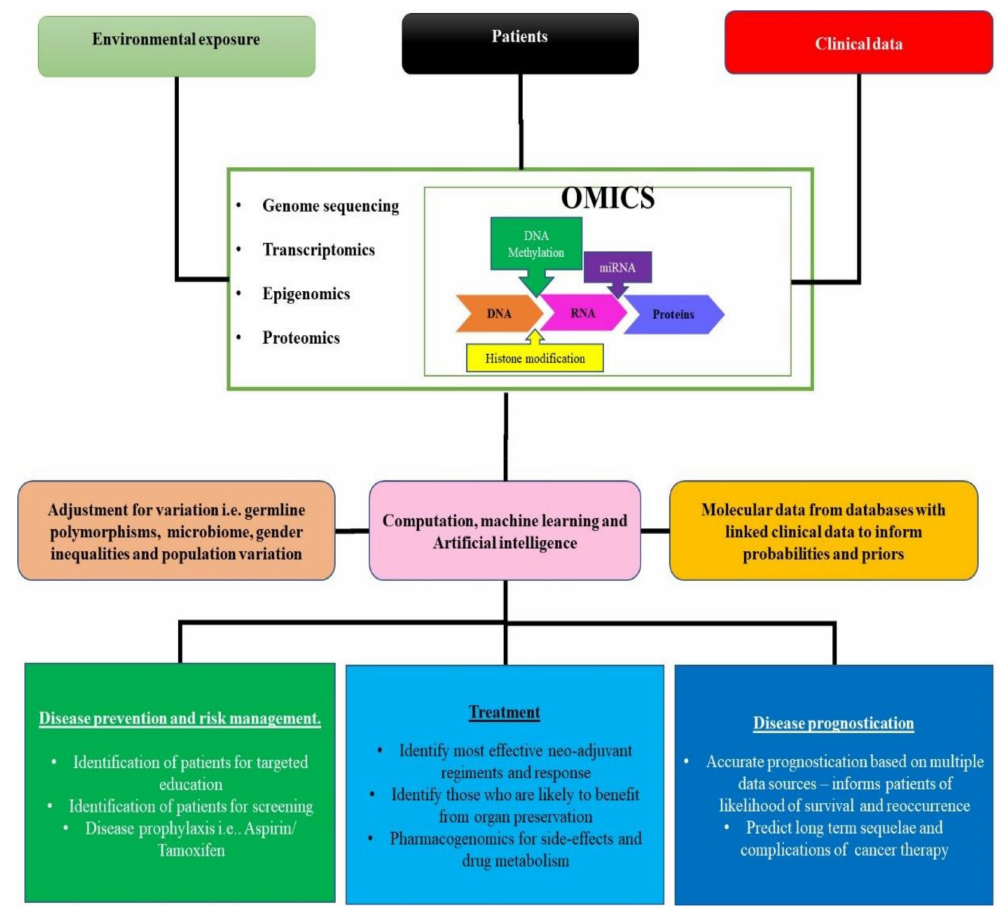
Figure 6. Precision medicine enabling technologies. New technologies to characterize the profiles of genetic mutations, transcriptome changes, epigenome changes and proteomic changes that are specific to various populations and diseases such as PCa or ECa have been developed. These techniques give rise to vast amounts of data. In order to analyse and curate these data, there are new machine learning and artificial intelligence networks and algorithms available. This will also allow the integration of this vast amount of sequencing data with data from other sources. The end results of the generation and analysis of this data will be the ability to implement precision medicine, resulting in improved disease prevention, management, treatment, and prognostic